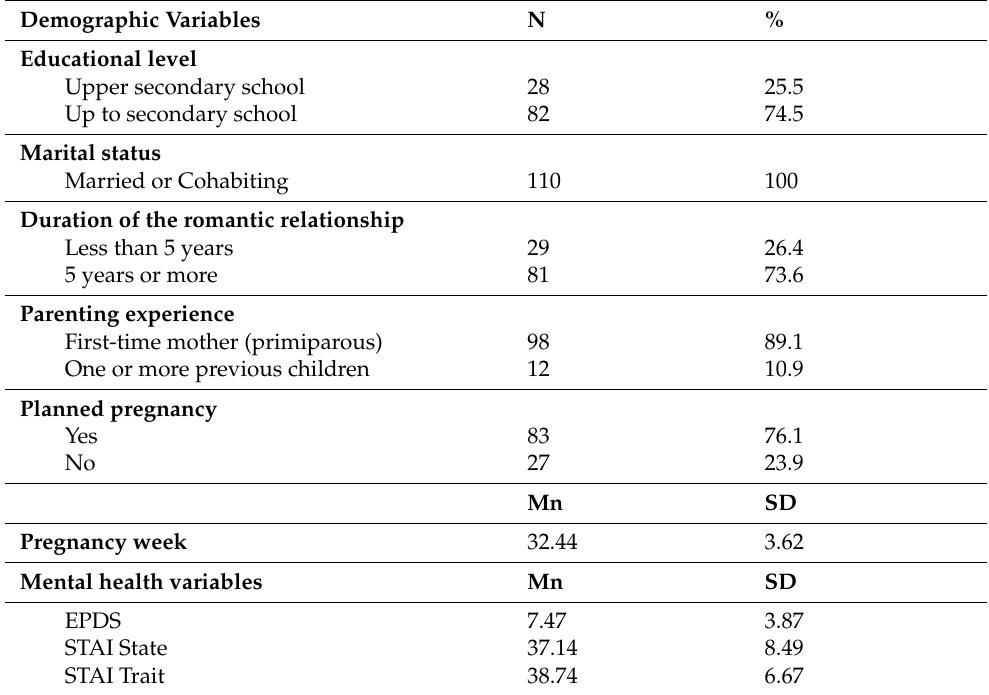
Table 1. Descriptive statistics of demographic and mental health variables (N